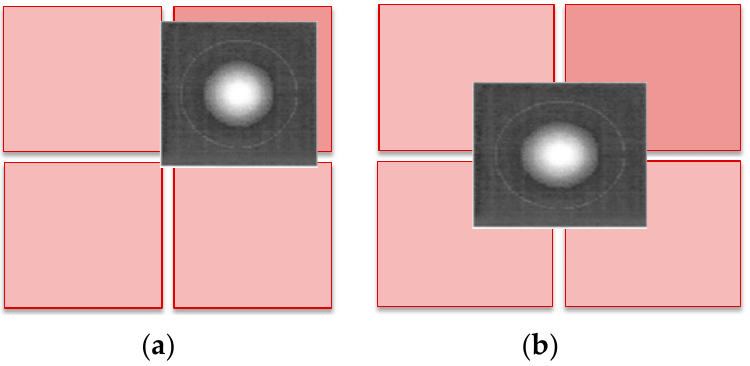
Figure 4. ( a ) The image of a point source is in general not aligned with a pixel center. ( b ) When in the extreme, limiting case, the image falls on the corner of four pixels, the detected signal in upper right pixel is equal to the noise in three neighboring pixels. In fact, there is no image detected against the noise, or possibly a broadly blurred image.